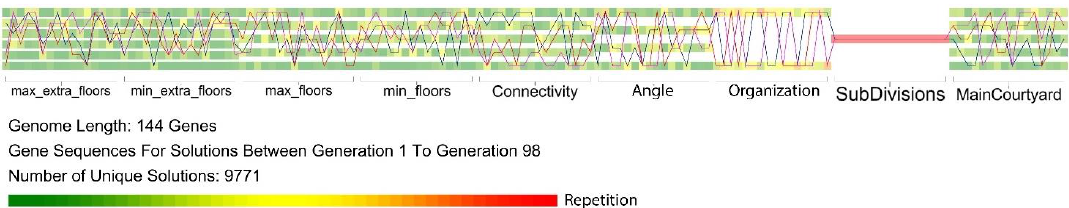
Figure 12. Geometric representation of each of the three selected phenotypes’ genomes. In the graph above, phenotypes are represented through the following polylines: Red — Phenotype 2, Blue — Phenotype 54, and Magenta — Phenotype 52.